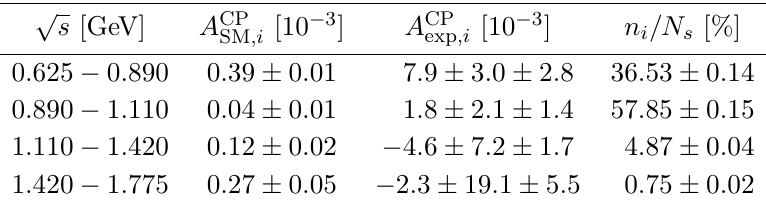
Table 2 . Updated SM predictions including the detector efficiencies (the second column) and the Belle measurements (the third column) of the CP asymmetries A CP of signal events n i per mass bin divided by the number of total events N s (the fourth column) for four different Kπ invariant-mass bins (the first column)